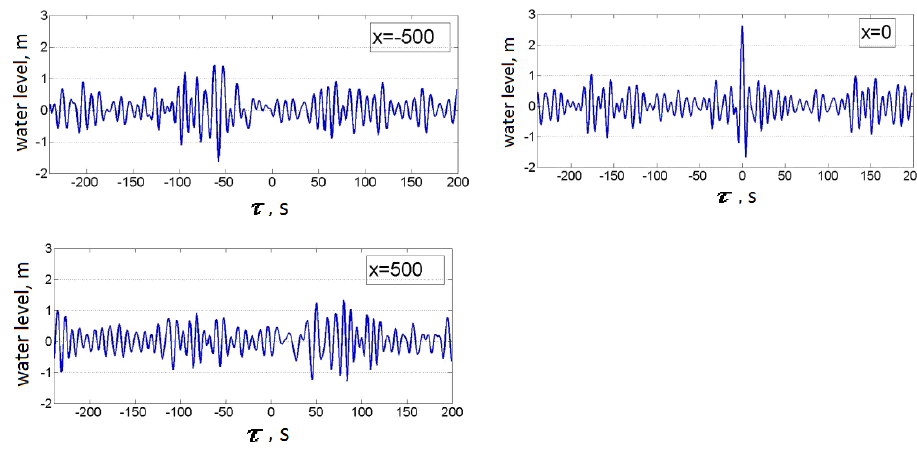
Fig. 5. Time series of the wave field at different distances (m) from the zone of anomalous wave.